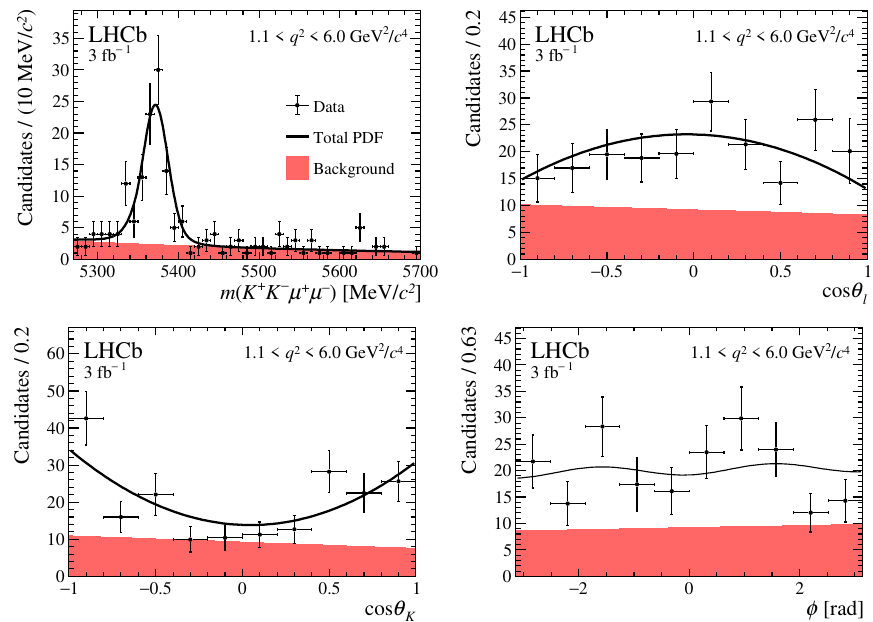
Figure 27 . Mass and angular distributions of B 0 1 . 1 < q 2 < 6 . 0 GeV 2 /c 4 for data taken in 2011–2012. The data are overlaid with the projections of the fitted